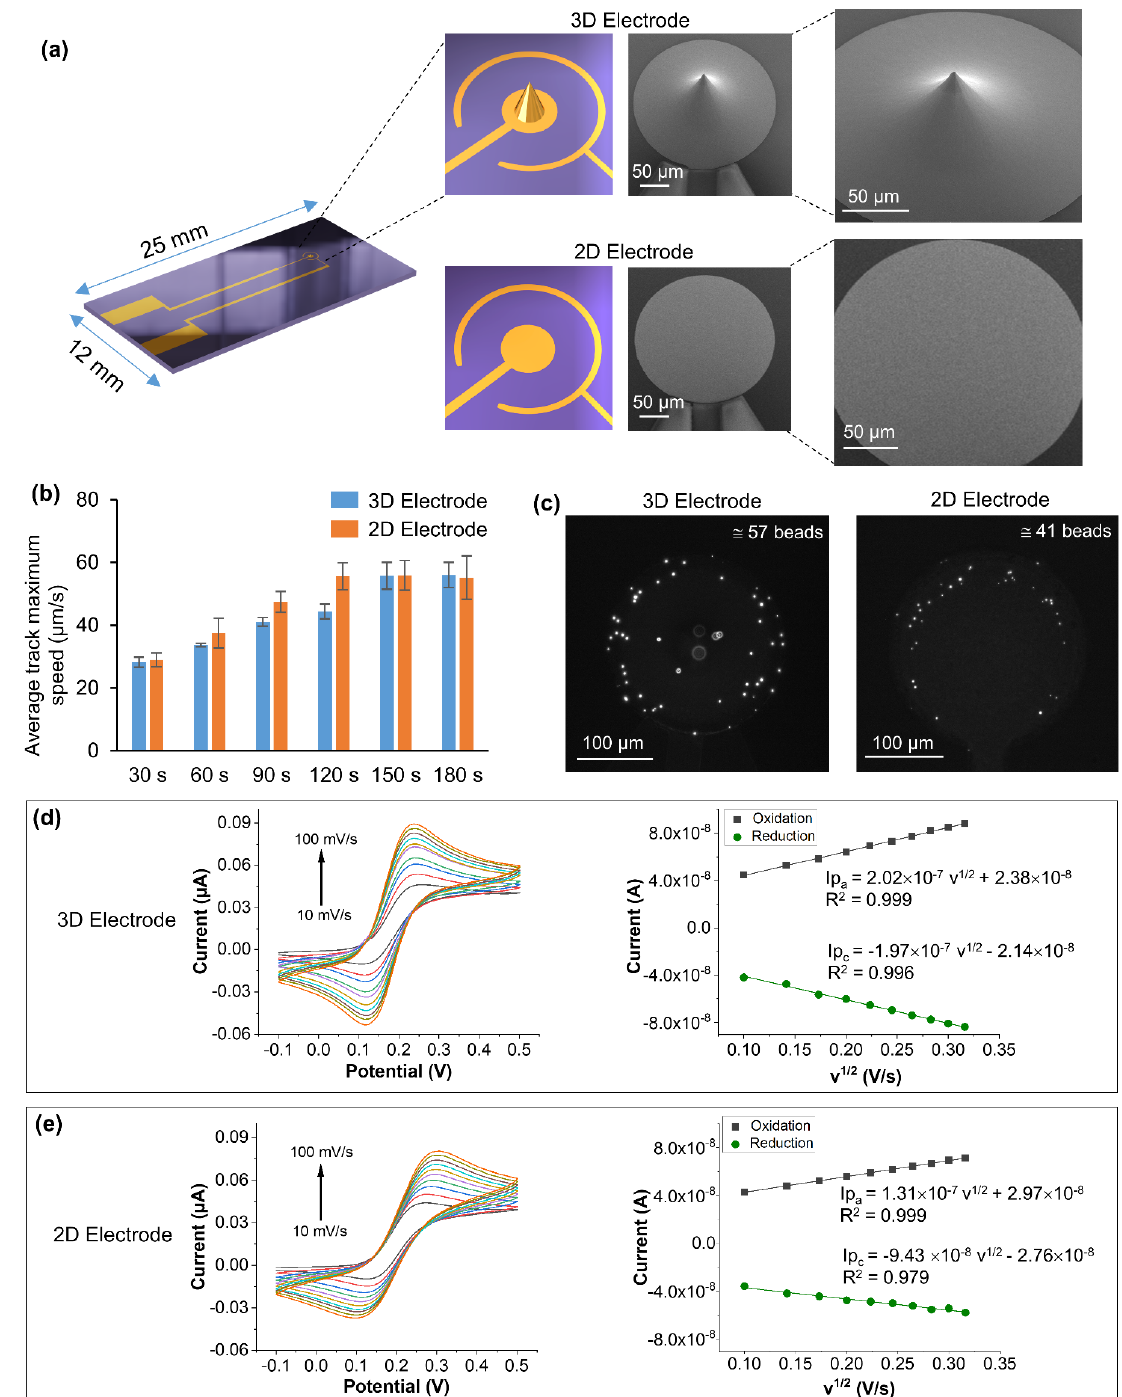
Figure 6. ( a ) Shows the schematic and SEM images of the 3D and 2D electrodes (inner electrodes). A single tip was formed in the middle of the inner electrode compared to the 2D electrode. ( b ) Comparison of the average maximum speed of 3D and 2D devices calculated in the intervals of 30 to 180 s. ( c ) Fluorescence images of 3D and 2D electrodes after the binding of streptavidin fluorescent beads onto the biotin-functionalized electrodes. The ac-EHD parameters used were 100 Hz, 4Vpp. ( d , e , left) cyclic voltammograms were obtained using 0.1 M KCl containing 1 mM potassium ferrocyanide for 3D and 2D electrodes at different scan rates (10 mV/s to 100 mV/s). ( d , e , right) present the plot current (I) vs. v 1/2 for 3D and 2D electrodes, respectively.